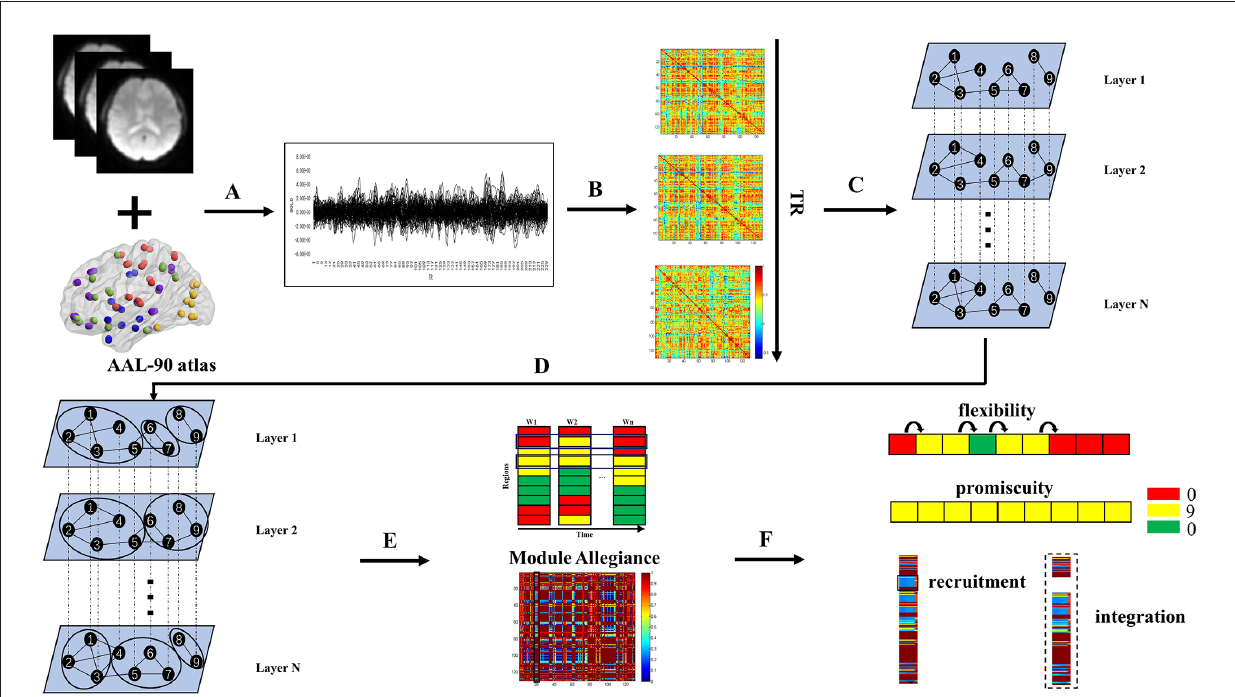
FIGURE1 Schematic overview of the experimental approach. (A) Times series were extracted from AAL-90 atlas defined regions of interest using resting state functional MRI data. (B) A sliding window strategy (length/step = 100/2 s, 141 windows in total) was used to generate interregional coherence matrices over time. (C) The same nodes were connected in adjacent time slices to construct a multilayer network for each participant. (D) Dynamic community structure was detected by maximizing a multilayer modularity quality function. (E) The module allegiance matrix was calculated. (F) Dynamic properties were calculated.